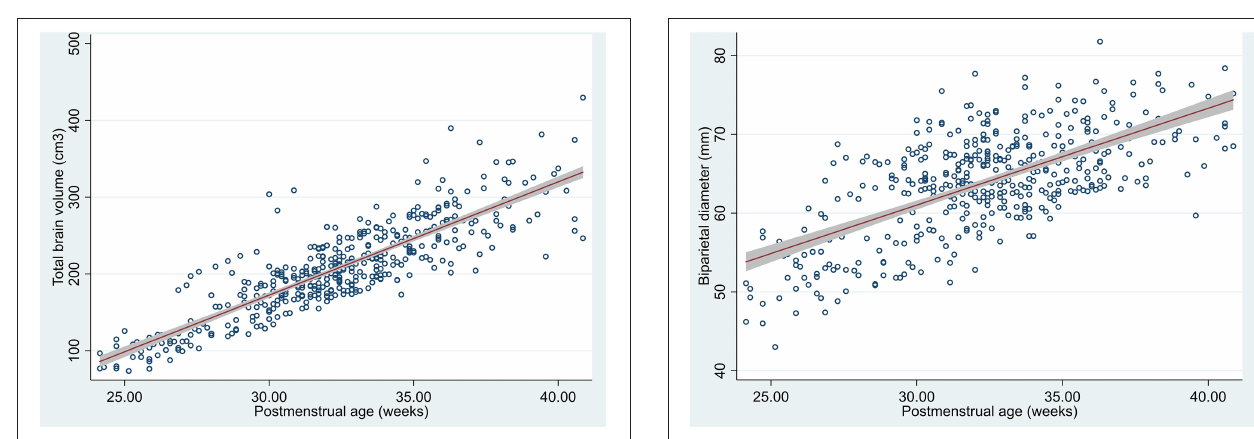
FIGURE 4 | Scatterplot of biparietal diameter by post-menstrual age measured in US, predicted mean and 95% confidence interval of the population means.